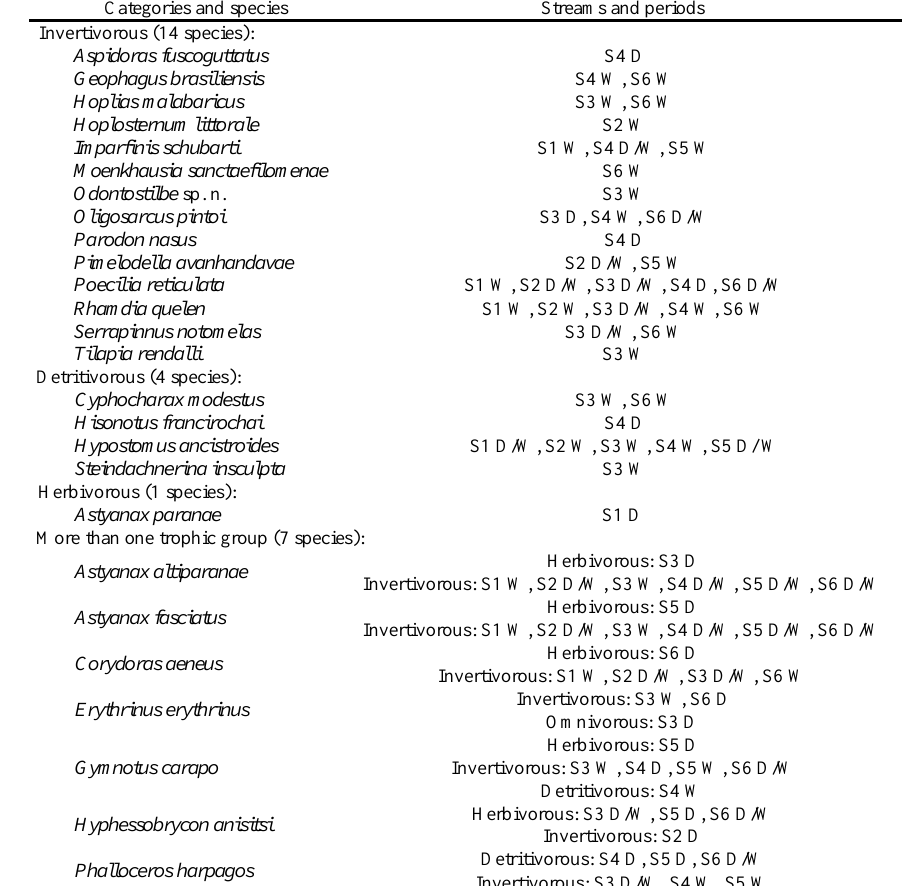
Table 4. Trophic categories of each species examined of six stream stretches (S1-S6) in the dry (D) and wet (W)